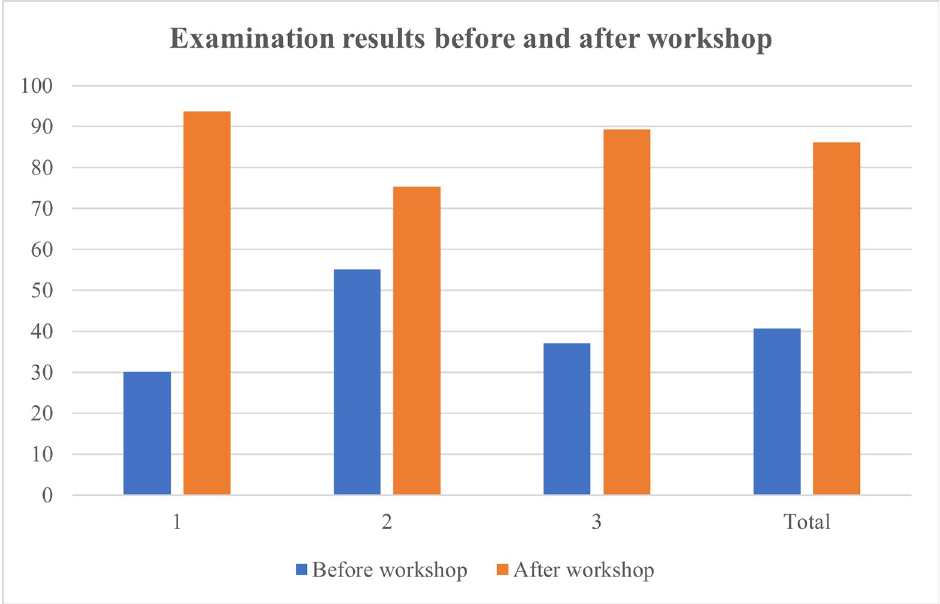
Fig 4. Comparison of combined knowledge assessment percentage results before and after training for all three workshops. 1 –first training workshop; 2 –second training workshop; 3 –third training workshop.